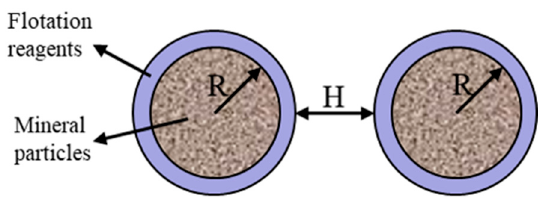
Figure 3. Schematic diagram of interaction between mineral particles.